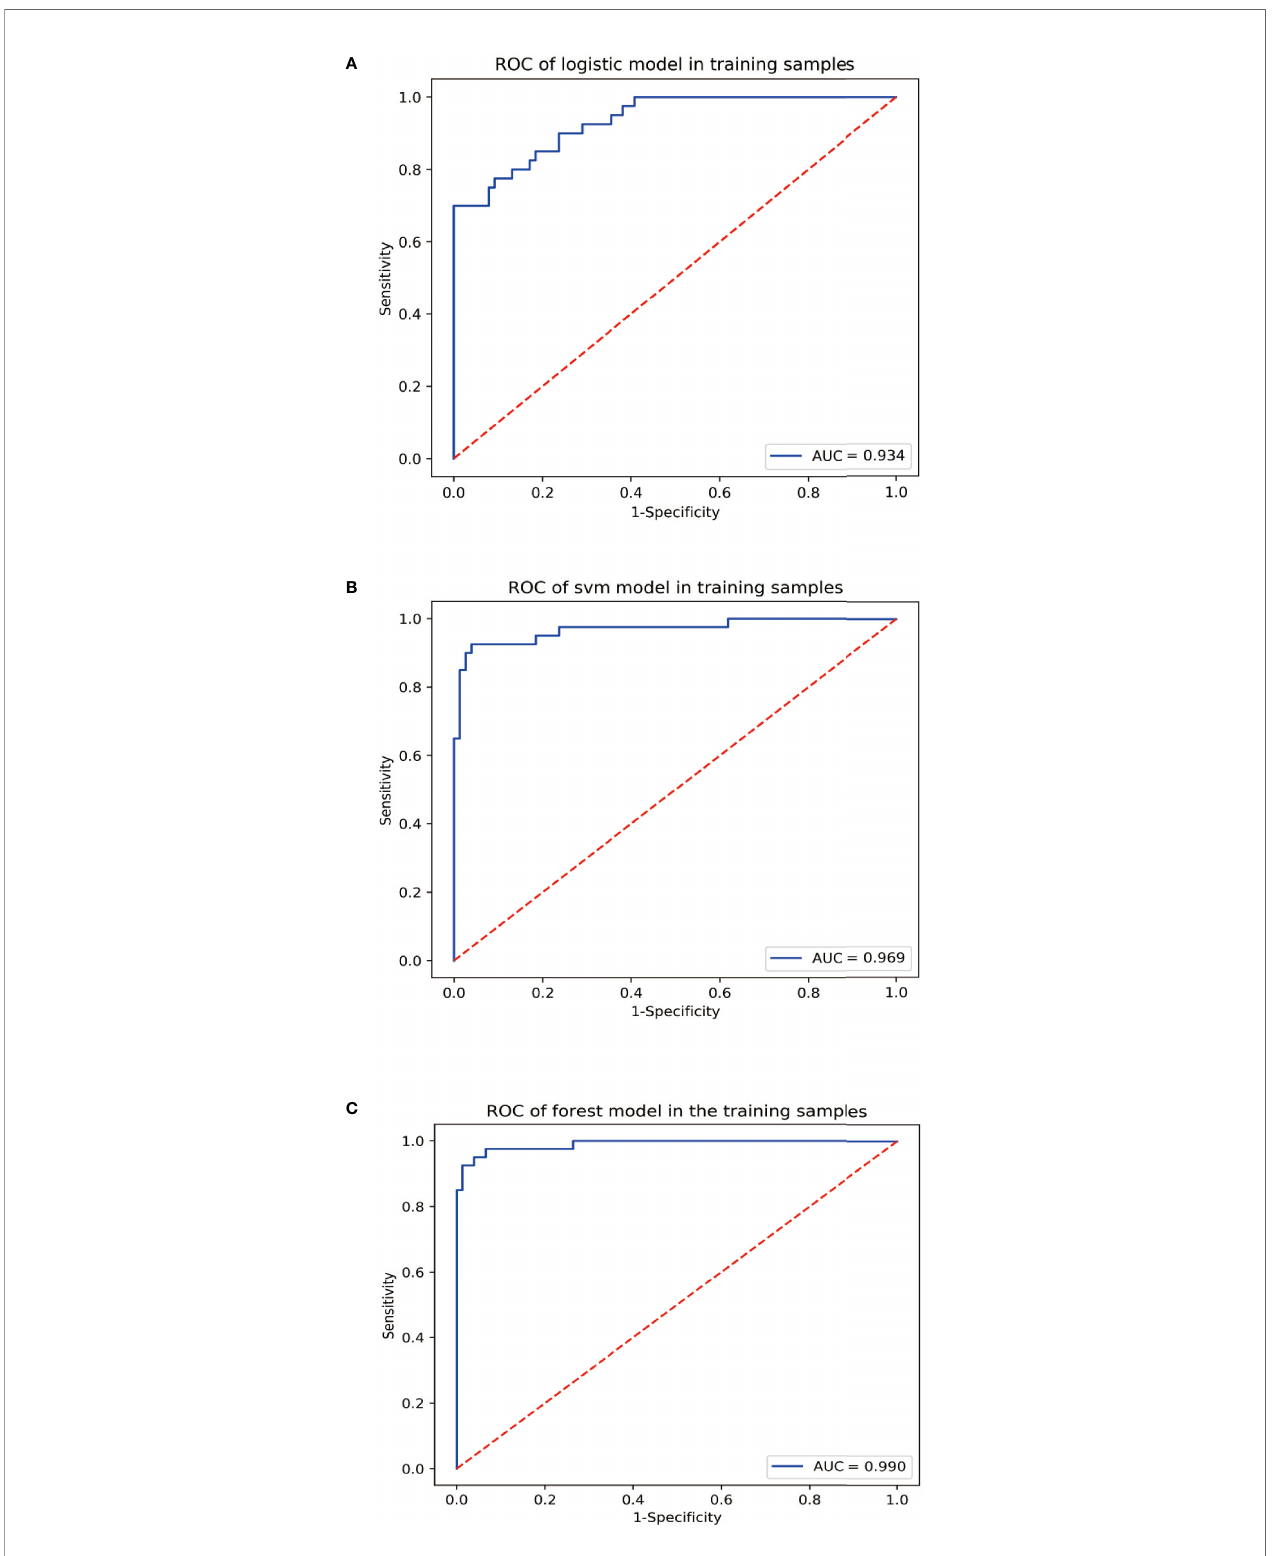
FIGURE 2 | The receiver operator characteristic (ROC) curves of the radiomics models for discriminating the normal controls (NM) and subcortical ischemic vascular cognitive impairment with no dementia (SIVCIND) subjects. (A) ROC curve of logistic regression (LR) (area under the ROC curve (AUC) = 0.934). (B) ROC curve of support vector machine (SVM) (AUC = 0.969). (C) ROC curve of random forest (RF) (AUC =